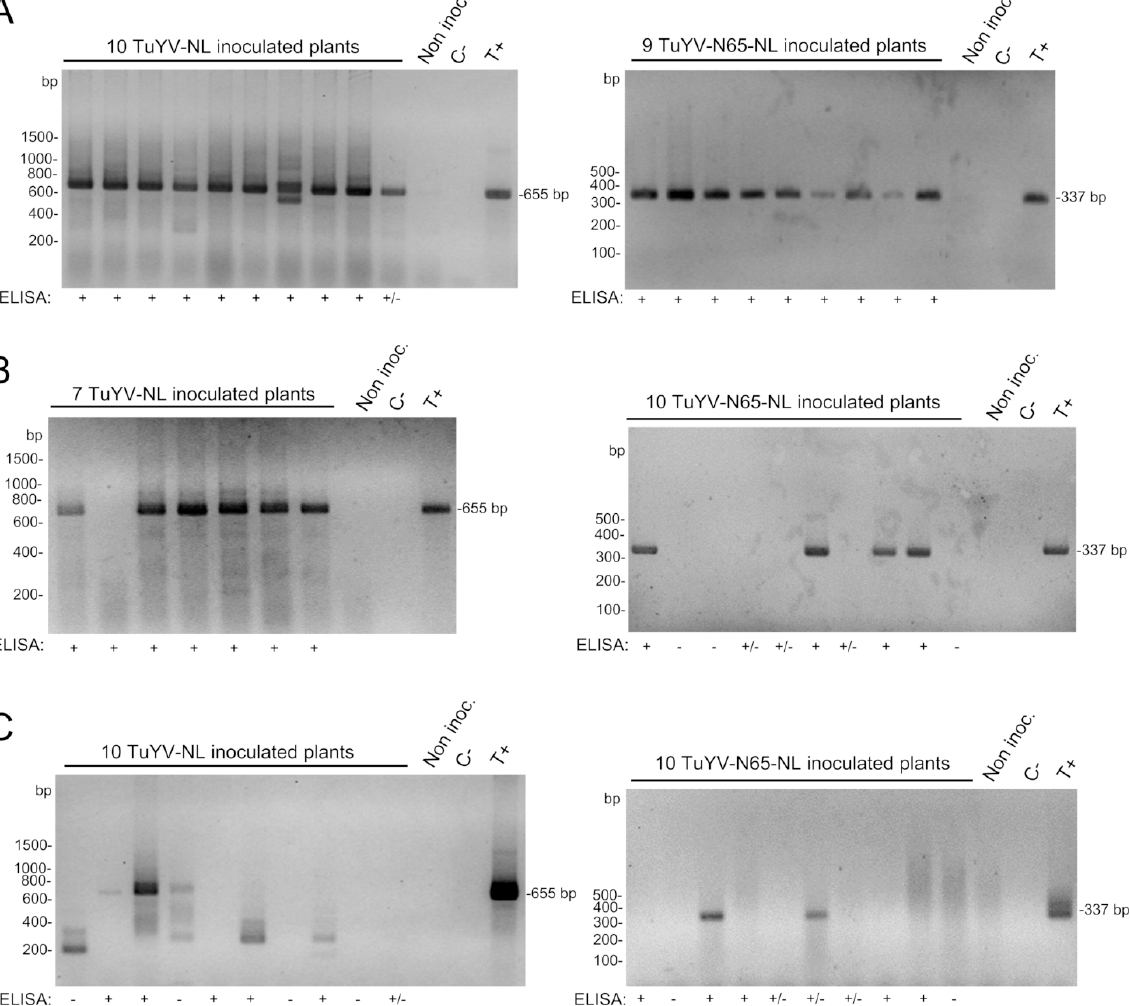
Figure 3. Analysis of viral progeny by reverse transcription ‐ polymerase chain reaction (RT ‐ PCR) in non ‐ inoculated (systemically infected) leaves of ( A ) Nicotiana benthamiana , ( B ) Montia perfoliata , and ( C ) Arabidopsis thaliana agro ‐ infiltrated with TuYV ‐ NL or TuYV ‐ N65 ‐ NL. Total RNA was isolated two weeks post ‐ inoculation from plants that were positive in ELISA (+), negative in ELISA ( − ), or had an OD value just above the threshold value in ELISA (+/ − ). For PCR, primers binding to the beginning of the NanoLuc sequence and to the 3 ′ UTR of the TuYV genome were used. An amplicon of 655 bp was expected for TuYV ‐ NL and 337 bp for TuYV ‐ N65 ‐ NL. Non ‐ inoc., non ‐ inoculated plants; C ‐ , non ‐ template control, T+, positive plasmid control (pTuYV ‐ NL for the left panel and pTuYV ‐ N65 ‐ NL for the right panel); bp, base pairs.